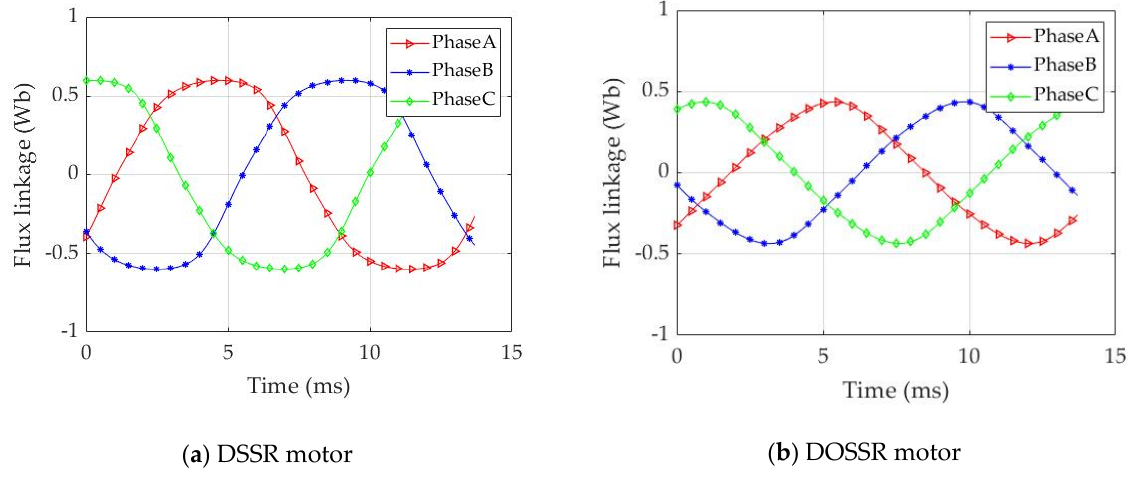
Figure 14. Flux linkage for the DSSR motor with PM thickness of 4.5 mm and the DOSSR motor with PM thickness of 5 mm.